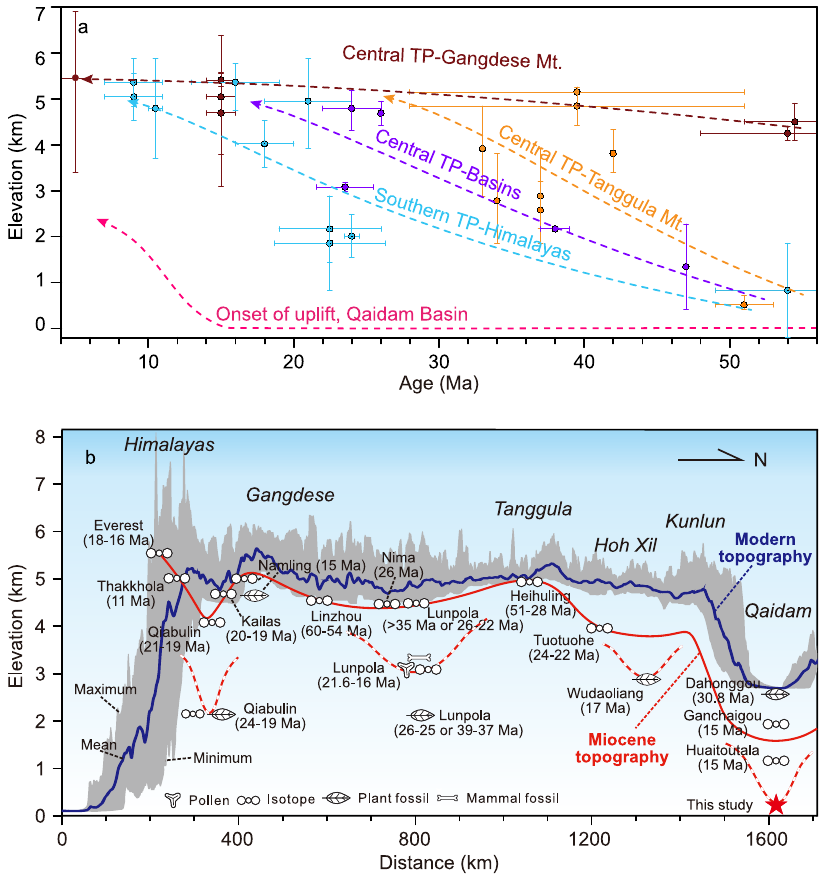
Fig. 5 Synthesis of the uplift history and topographic evolution of the Tibetan Plateau. a Paleoaltitudes at various parts of the Tibetan Plateau (TP) plotted against age. The brown, orange, purple and blue dots indicate estimated paleoelevations of the Central TP, including the Gangdese Mountains, Qiangtang (Tanggula) Mountains, and sedimentary basins in the Bangong-Nujiang Suture, and the Himalayas (South TP) respectively. The red line indicates the uplift of the Qaidam Basin since the mid-Miocene. b Plateau topography by roughly the early Miocene, in comparison with modern one. The red solid line indicates paleolatitudes mainly based on the isotope paleoaltimetry while the dashed line shows relatively low elevations of basins, largely based on plant and mammal fossils. A substantially lower northern plateau and the existence of a series of east-west orientated deep valleys/basins by the early Miocene could be observed. Paleoaltitude data and errors (in both paleolatitudes and ages, mostly expressed in 1 σ or 2 σ uncertainty) are referred to summaries in ref. 49 – 51 and provided in Supplementary Note 5 and Supplementary